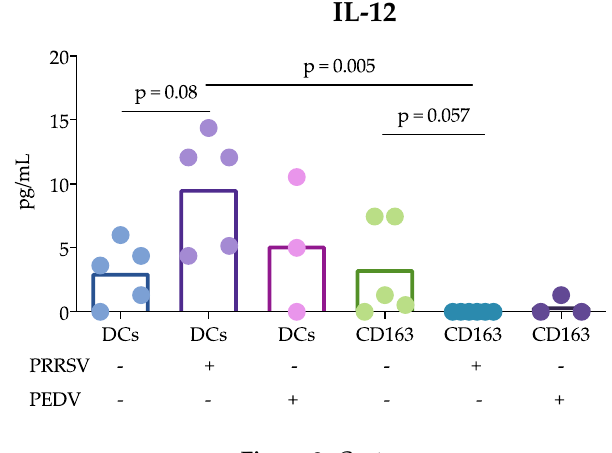
Figure 2. Cytokine expression of splenic cDCs and CD163 + cells in response to virus. cDCs and CD163 + cells were stimulated with porcine epidemic diarrhea virus (PEDV) or porcine reproductive and respiratory syndrome virus (PRRSV) for 24 h, and cytokine production was analyzed by qPCR. The results were analyzed with the 2 −ΔΔCt method and are presented as relative increments. In each figure, the bars represent the mean, and each point represents one pig. Data were analyzed with the nonparametric Kruskal-Wallis test (IFN- α and IL-4) or the Mann-Whitney (IL-10 and TGF- β ) test. Significant differences are indicated.